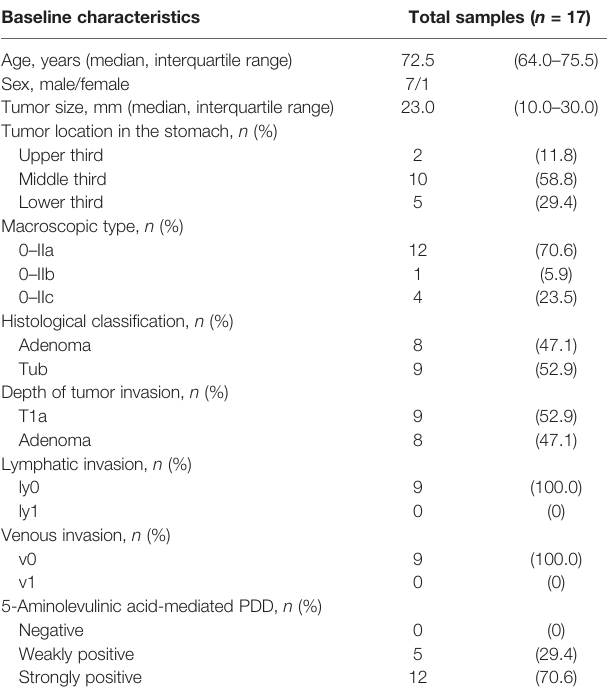
TABLE 3 | Characteristics of 17 multiple lesions in eight patients with early gastric cancer and/or adenoma. Baseline